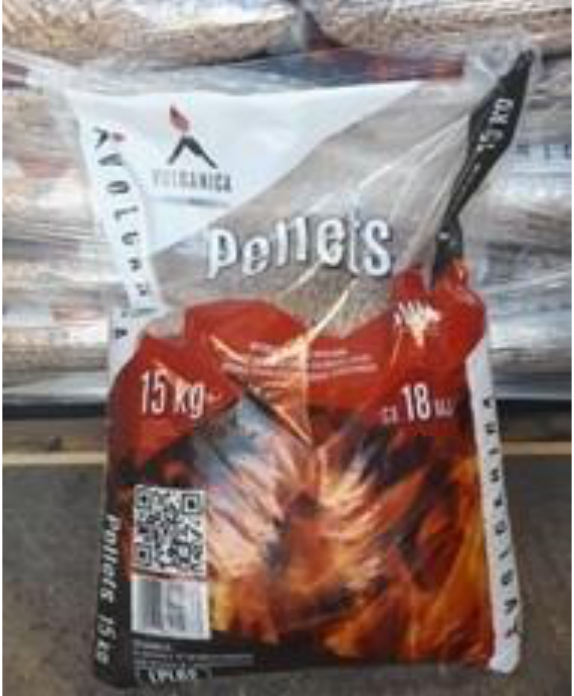
Figure 2 . Reference wood pellets. Figure 2. Reference wood